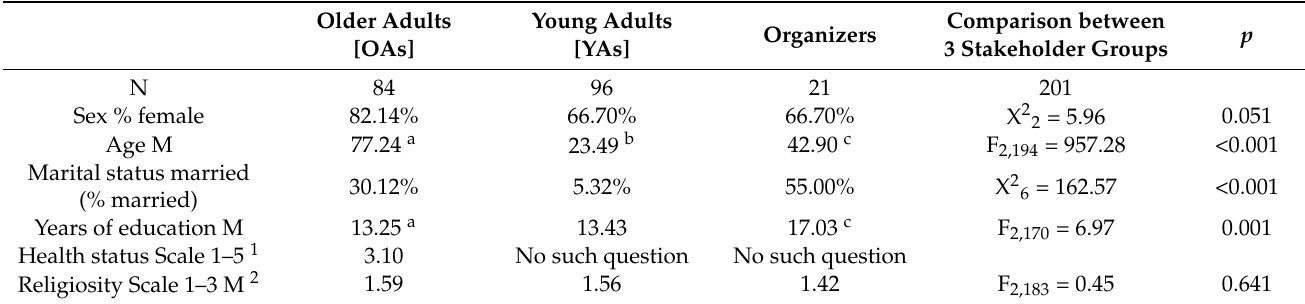
Table 1. Comparison of background variables of the different informants.